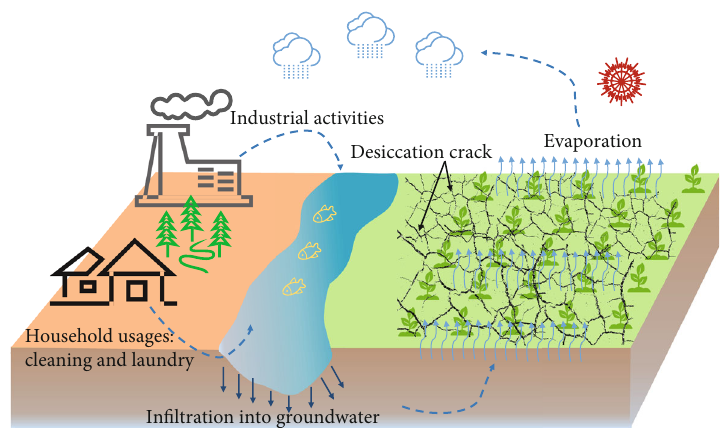
Figure 3: The source, discharge of grey water, and its e ff ects on the